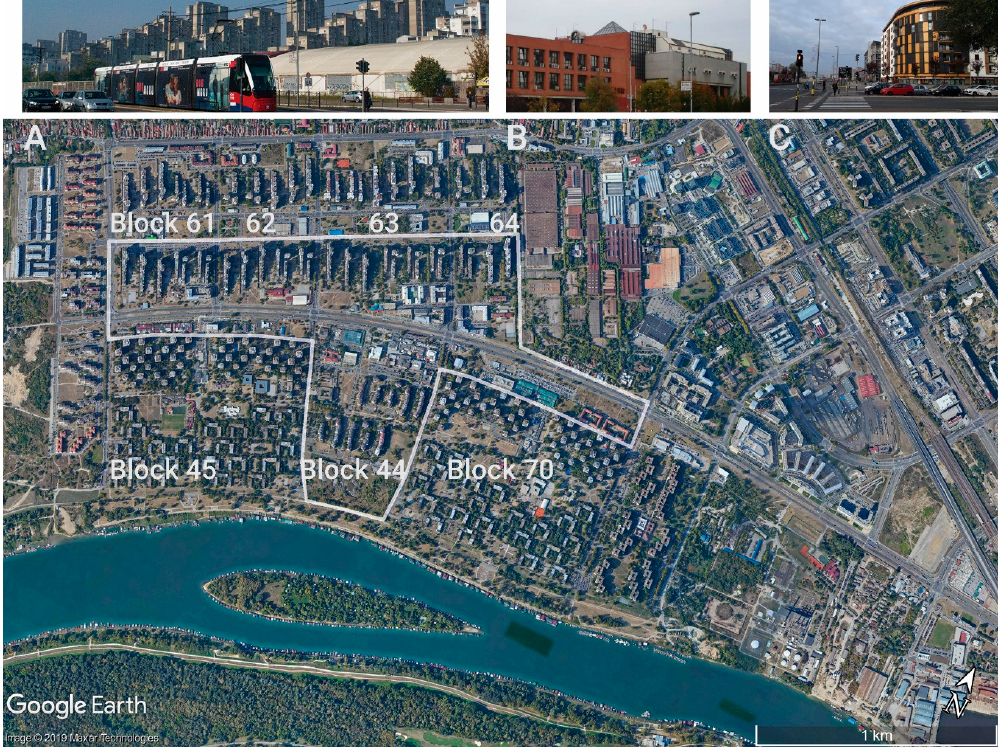
Figure 2. Case study area: Jurija Gagarina Street (Source: Google Earth, October 2019; Photos by the authors).